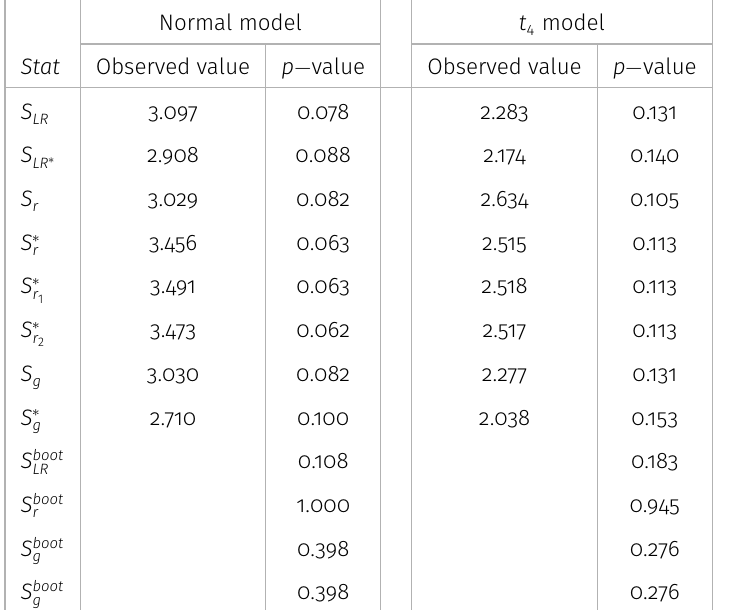
∶ 𝛿 = 0 in normal model and t 0 1